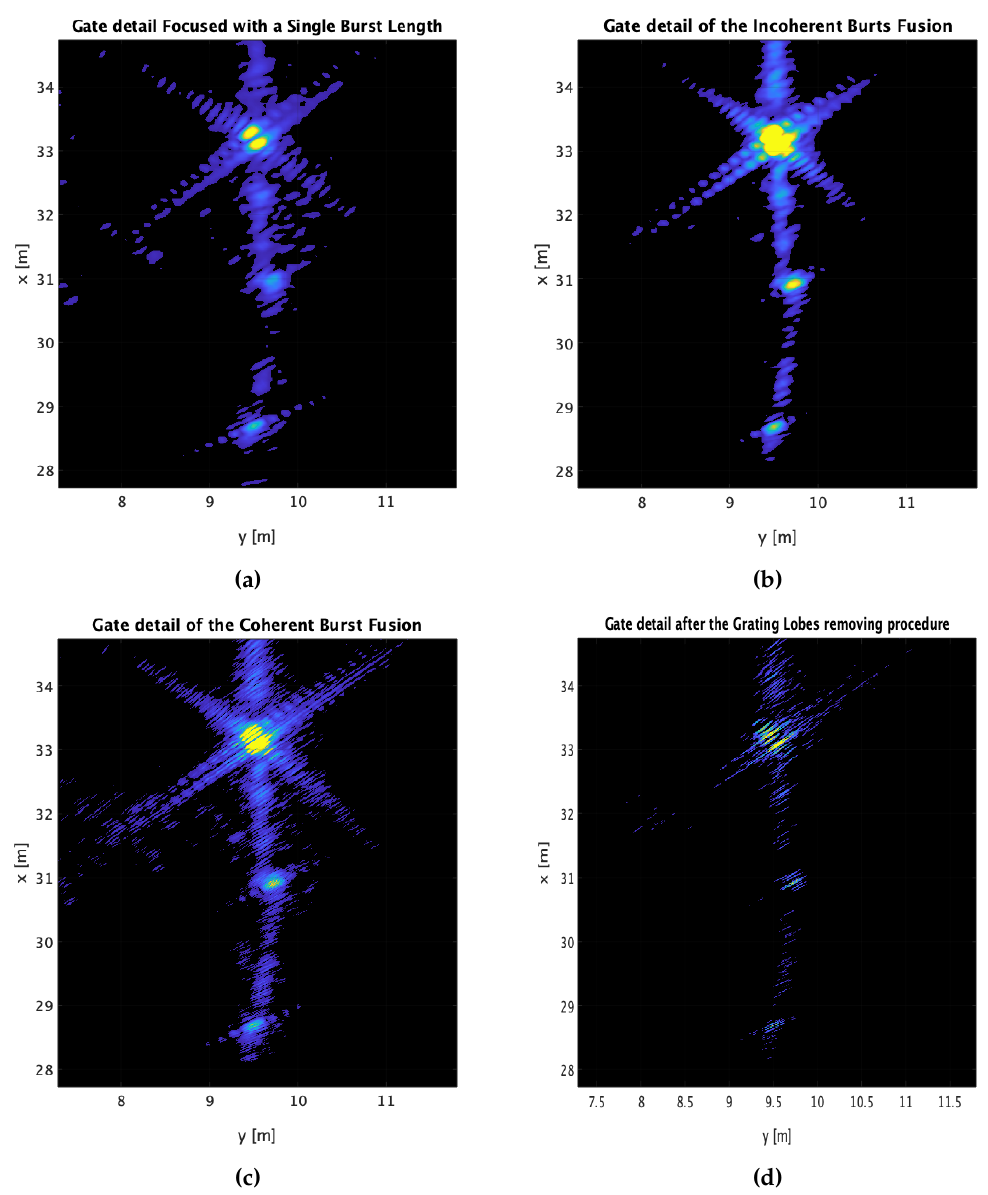
Figure 13. (a): Gate detail of a SAR image generated with the synthetic aperture of a single burst length. (b): Gate detail of a SAR image generated using the incoherent sum of the three bursts. (c): Gate detail of a SAR image generated using the coherent sum of the three bursts. (d): Gate detail of a SAR image generated using the grating lobes removing procedure.